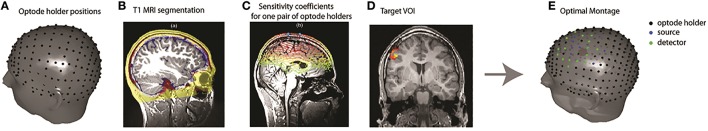
Overview of the fNIRS optimal montage methodology. (A) Optode holder positions based on the EEG 10/05 international system. (B) An anatomical head model was built from the classification of a T1 MRI into five tissue types. (C) Patient specific light sensitivity maps for each optode holder were estimated by Monte Carlo simulations. The sensitivity profiles of all possible pairs of optode positions were calculated. (D) Definition of the patient-specific target VOI, defined for instance from EEG-MEG source imaging results. (E) Optode montage optimization over the target volume using a branch and bound algorithm 4 sources (blue dots) 8 detectors (green dots) on each side.